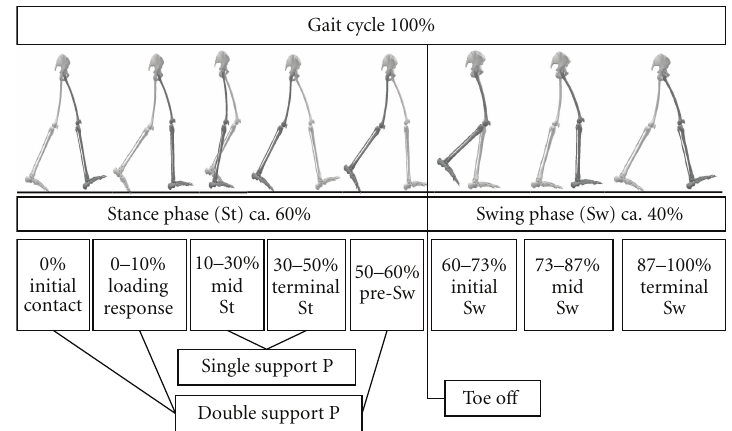
Figure 2: Normal gait cycle with approximated event timings (modified to Perry [6]).